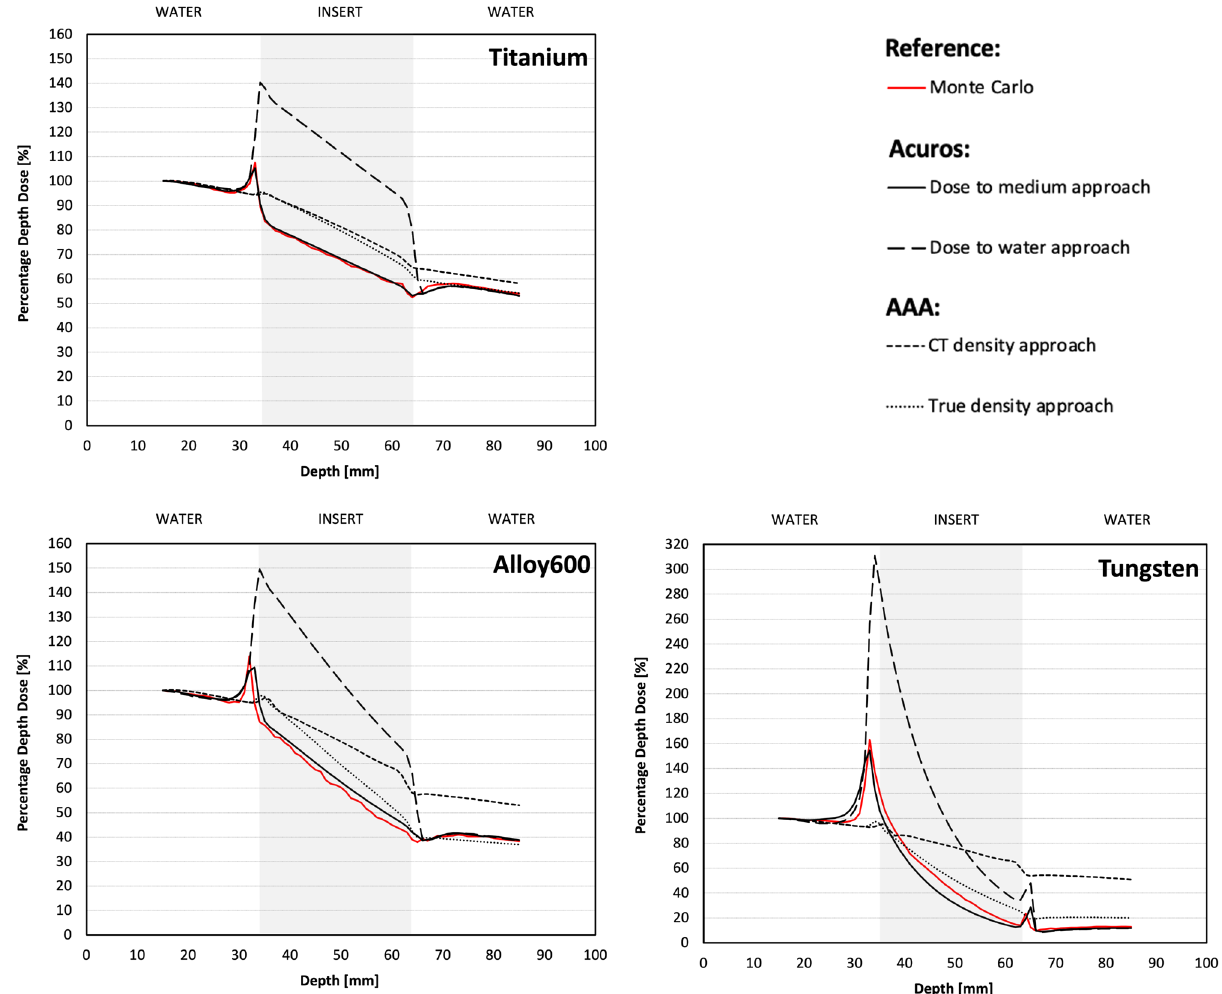
Figure 5. The comparison between PDDs obtained from Monte Carlo simulations performed for TPS condition (red line) and PDDs obtained from TPS calculations on standard CT reconstruction using different algorithms for titanium, alloy 600, and tungsten